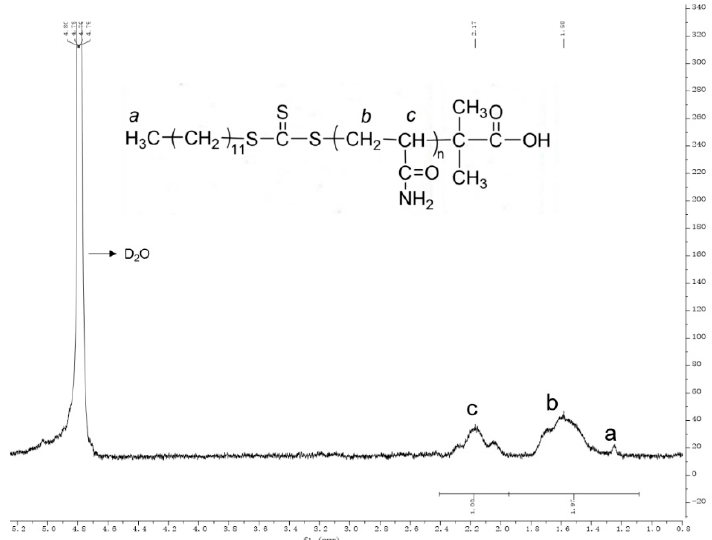
Figure 3. The 1 H NMR spectrum of PAM prepared via RAFT process in D 2 O.